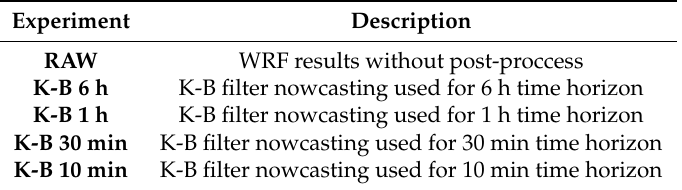
Table 2. Short explanation of the experiments tested in this study. The bold names on the left are the identifiers used hereafter for each